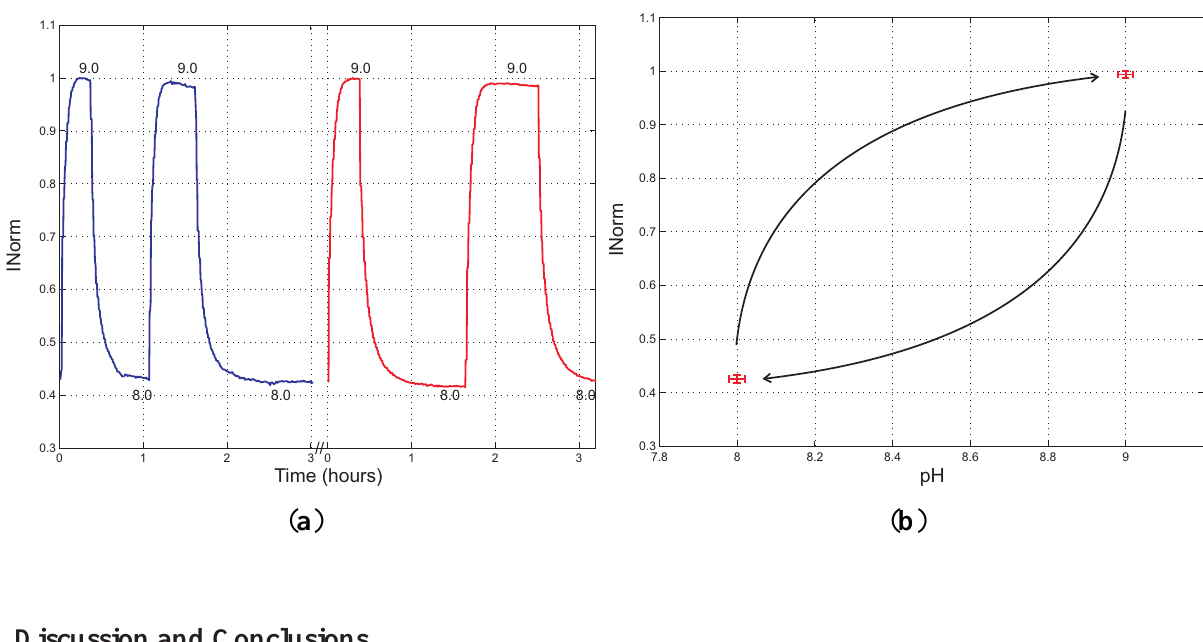
Figure 14. ( a ) Acquired I versus time changing the pH value between 8.0 and 9.0 to Norm evaluate the reproducibility of the pH sensor. Two tests were performed (blue line and red line) on two consecutive days. ( b ) Mean values and error bars of the I signal, measured Norm at pH = 8.0 and pH =